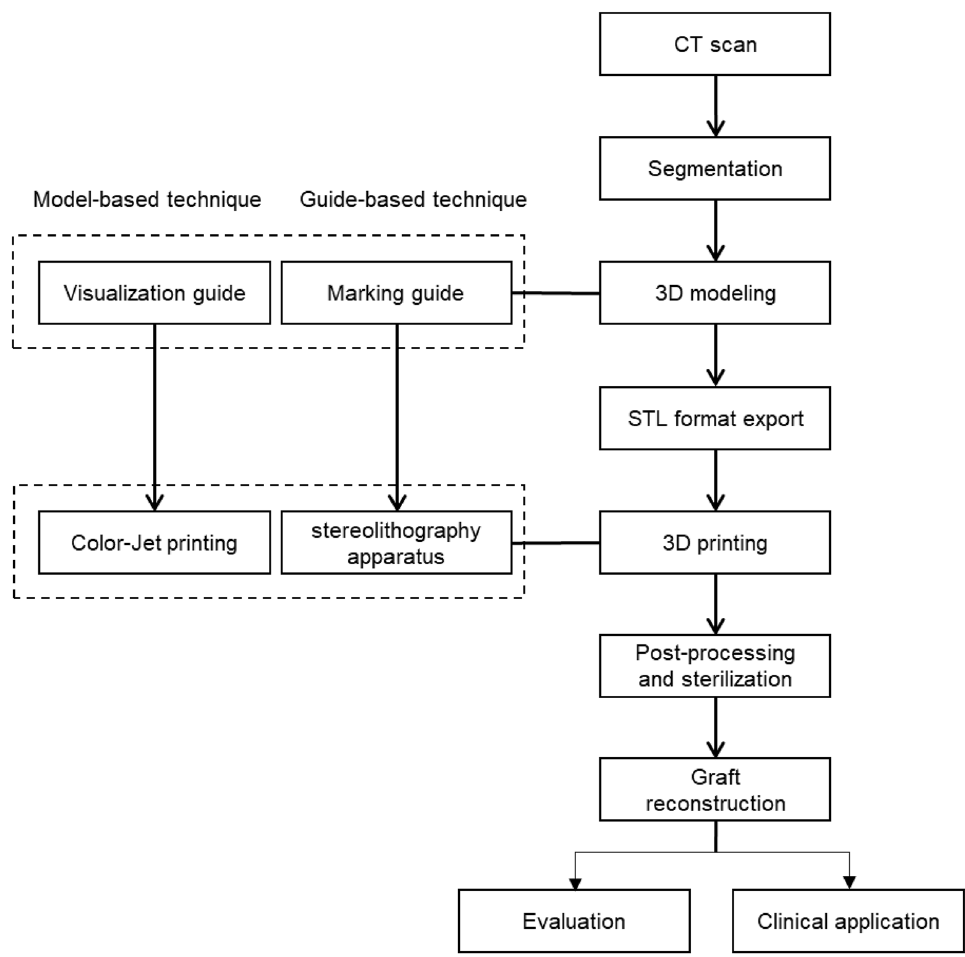
Figure 1. Overall process of two types of graft guide with MBT and